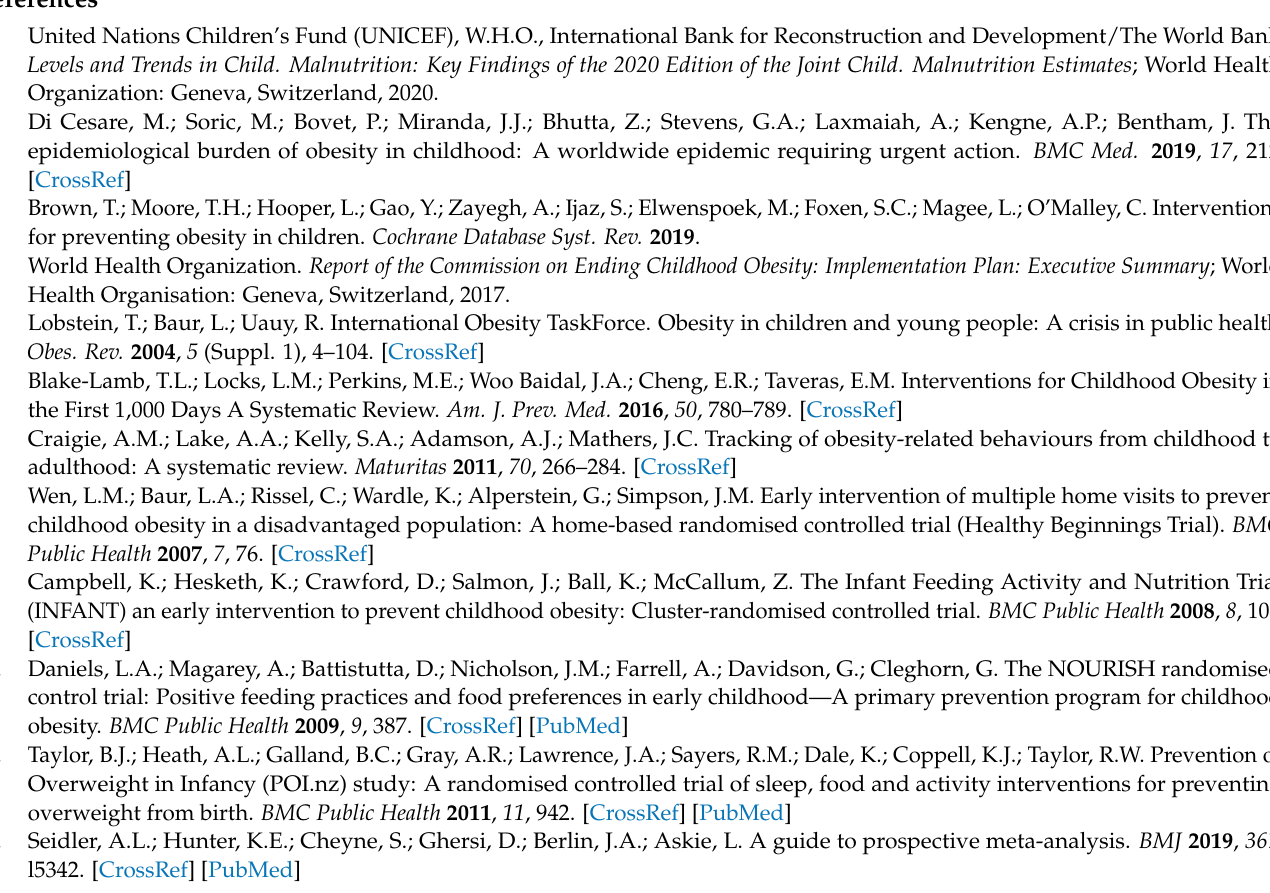
Table S5. Theoretical Models. Table S6. Funding Sources. Table S7. Effectiveness of trial intervention on secondary outcomes. Table S8. Risk of Bias (RoB 2.0) assessments. Figure S1. Risk of bias